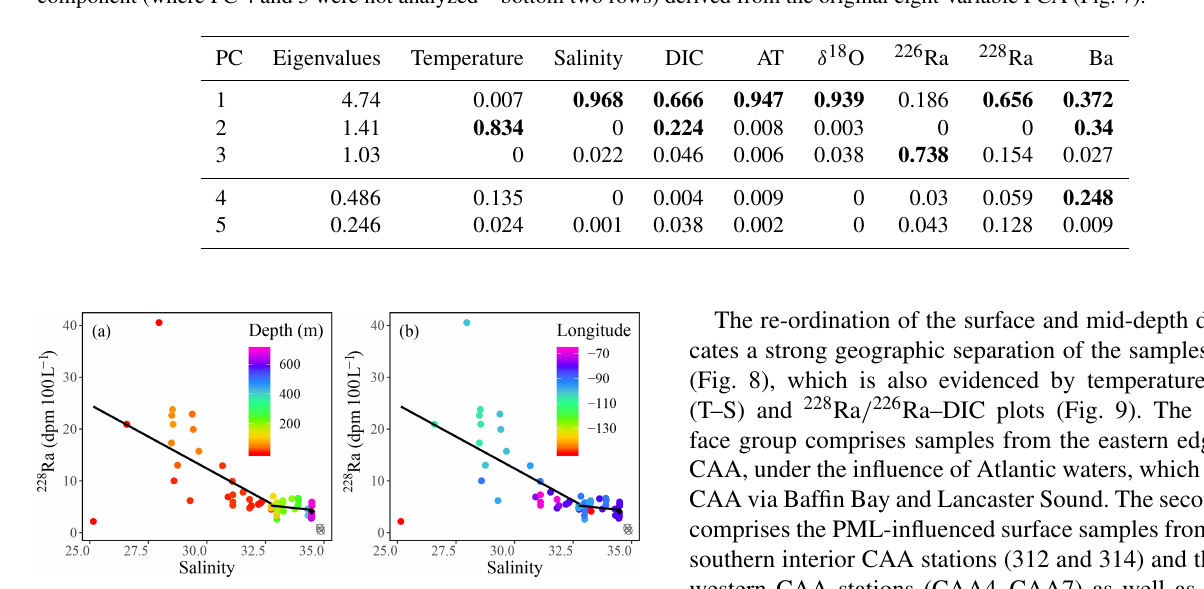
Table 1. Eigenvalues and normalized V 2 vectors for transformed and normalized temperature, salinity ( S P ), dissolved inorganic carbon (DIC), total alkalinity (AT), δ 18 O, 226 Ra, 228 Ra, and barium (Ba), where bold values represent significant weight attributed to that principal component (where PC 4 and 5 were not analyzed – bottom two rows) derived from the original eight-variable PCA (Fig. 7).